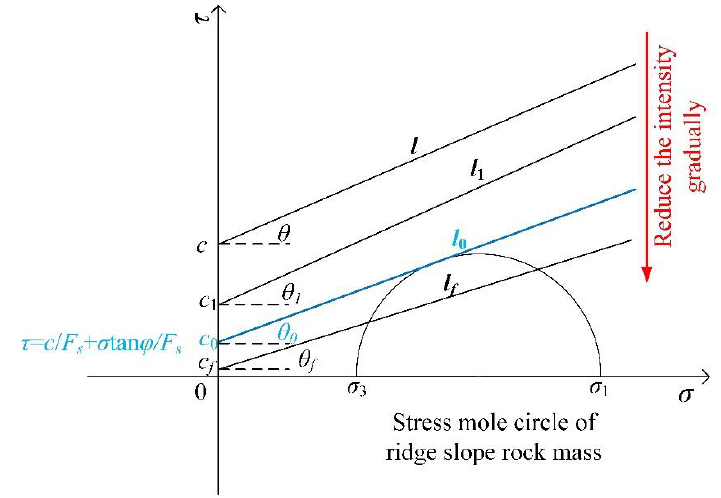
Figure 4. Principle of strength reduction method.